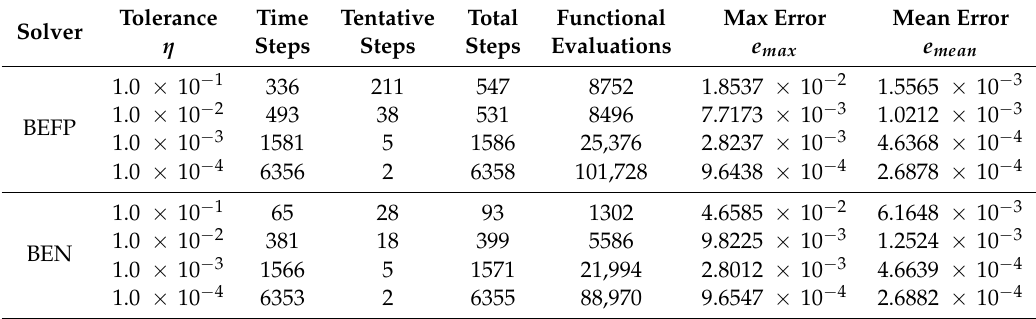
Table 4. Solution of mixed convection–diffusion and Burgers (MCDB) equation for µ = 0.5 using the shifted Strang–Marchuk splitting method.